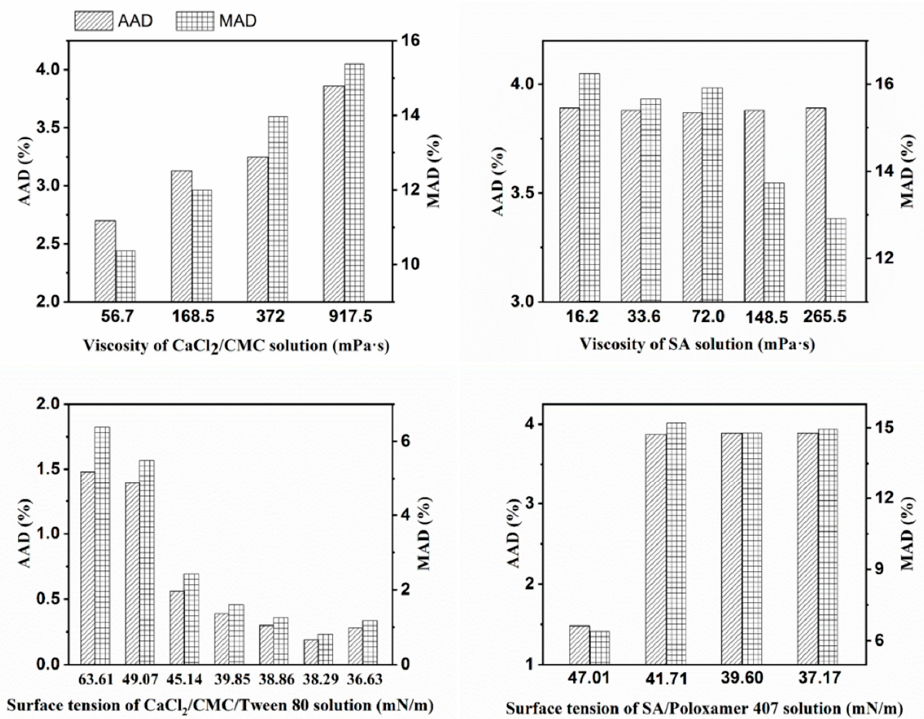
Figure 14. Error analysis of the diameter of mm-CaSA-Caps.